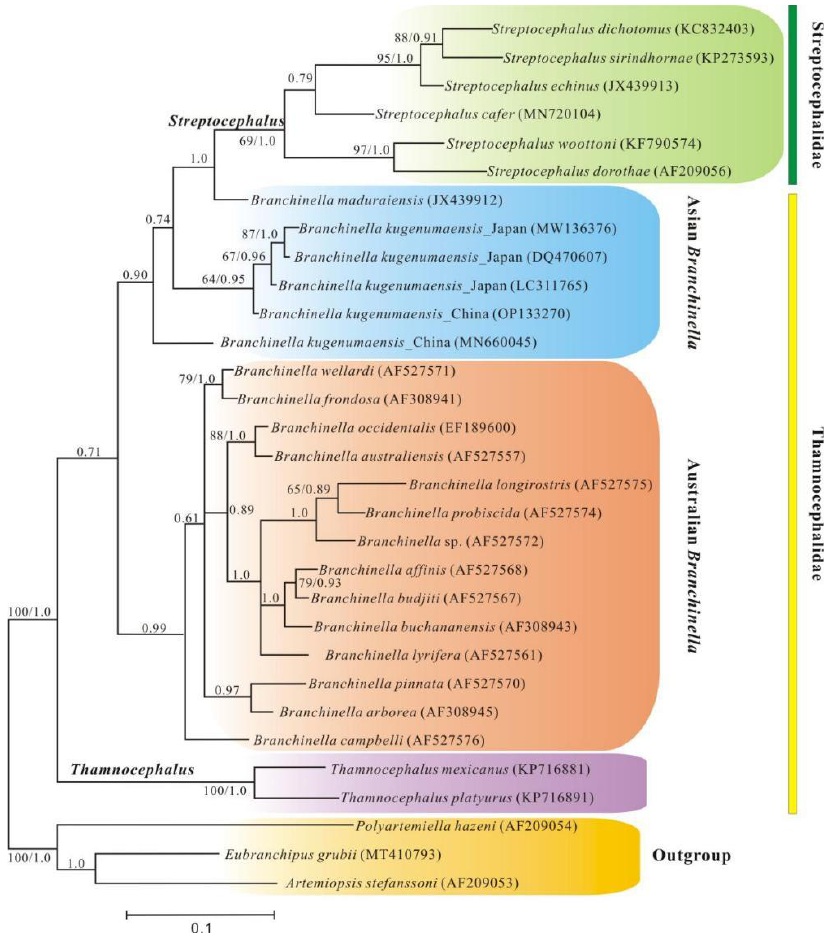
Figure 3. Phylogenetic trees showing the branching pattern within Thamnocephalidae (colour-coded) based on BI and ML of 16S rRNA gene. Bootstrap support values/Bayesian posterior probabilities are shown at the nodes. Support values less than 0.60 (BI) and 60 (ML) are not shown.